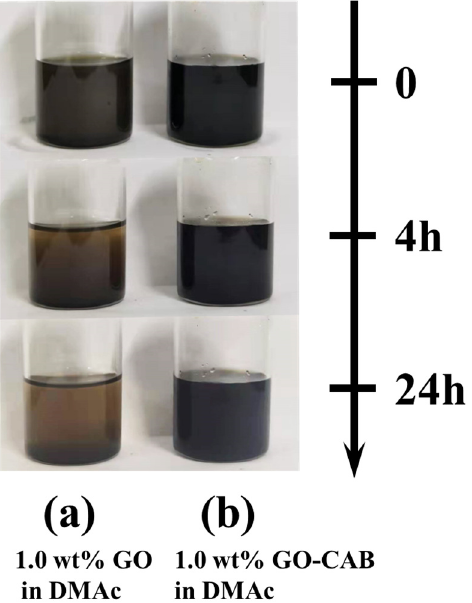
Figure 3. Photographs of 1.0 wt% GO ( a ) and 1.0 wt% CAB − GO ( b ) in DMAc.